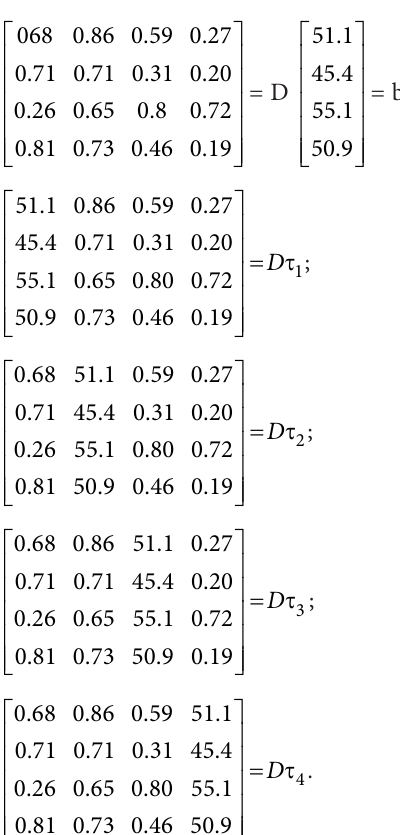
Table 2. Initial data for the construction of a system of normal equations on the example of the neighboring area for the model object for the study of land use NDVI Winter Years